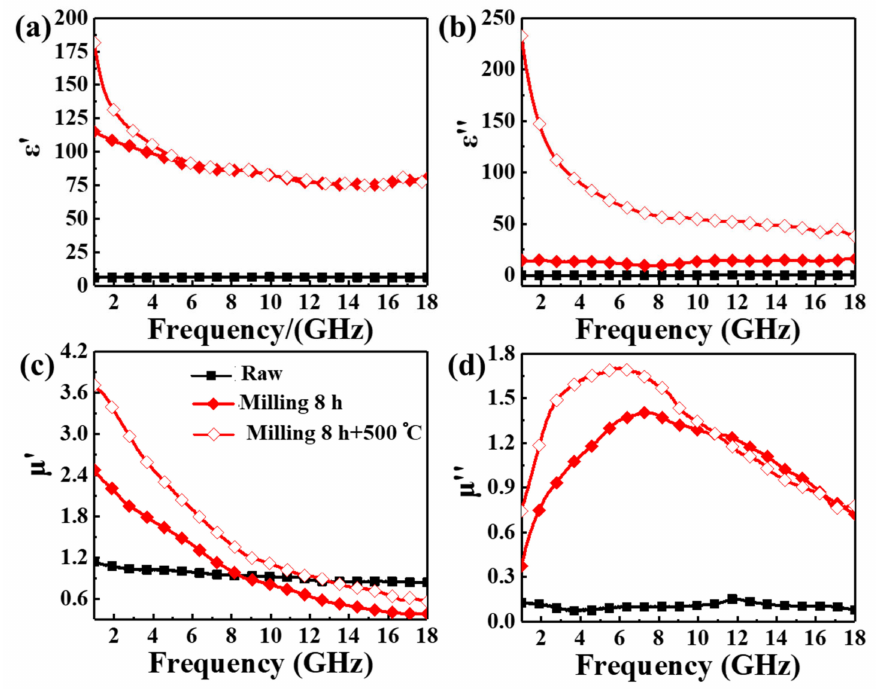
Figure 3. Variation of ( a , b ) complex permittivity and ( c , d ) complex permeability for FeCoCr powders during deformation-thermal co-induced